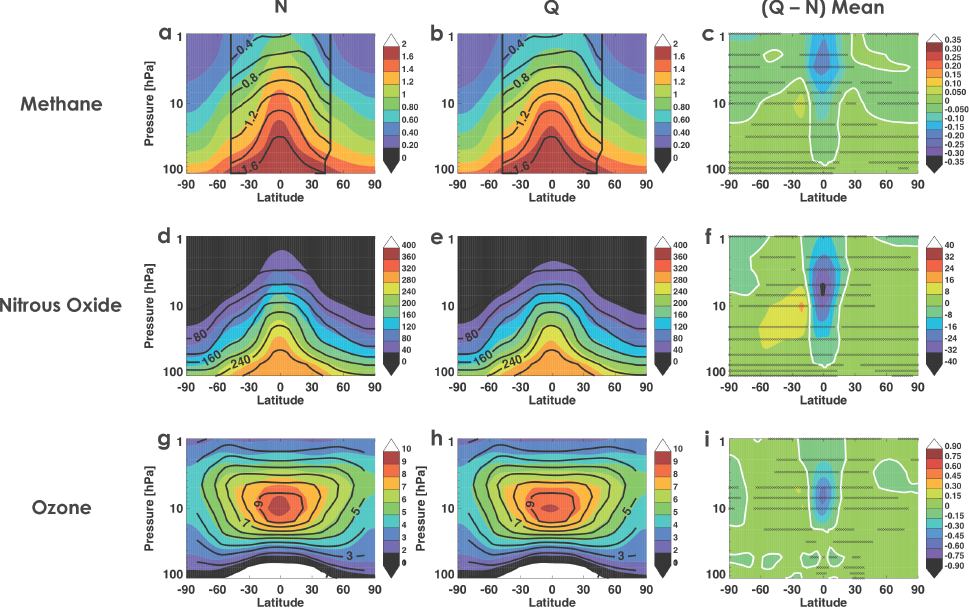
Figure 6 : As for Figure 3, but for (a–c) methane [ppmv], (d–f) nitrous oxide [ppbv] and 527 Fig. 6. As for Fig. 3, but for (a–c) methane (ppmv), (d–f) nitrous oxide (ppbv) and (g–i) ozone (ppmv). Black contours in (a) and (b) indicate the scaled HALOE climatology; black contours in (d–e) and (g–h) indicate MLS climatologies of nitrous oxide and ozone. (g–i) ozone [ppmv]. Black contours in (a, b) indicate the scaled HALOE climatology; 528 black contours in (d, e, g, h) indicate MLS climatologies of nitrous oxide and ozone. 529 in the Q simulation is generally in agreement with the 530 MLS ozone climatology (Fig. 6h). Thus, inclusion of the QBO improves model performance; the peak in ozone mix- ing ratio around 10 hPa is ∼ 0.8 ppmv too high in the